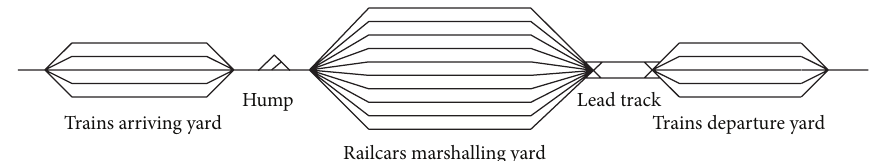
Figure 1: The layout of a typical marshalling station.